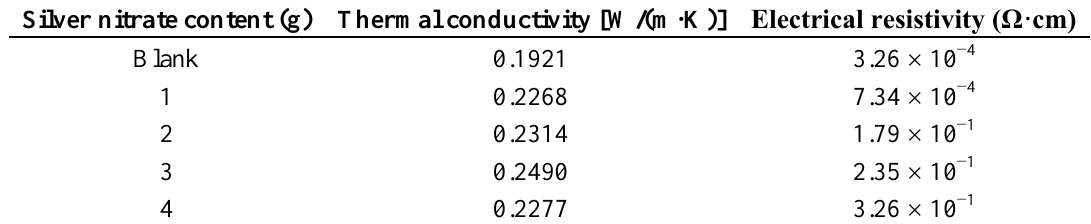
Table 1. Thermal conductivity and electrical resistivity of Ag/BC powder of composites prepared using various amounts of silver